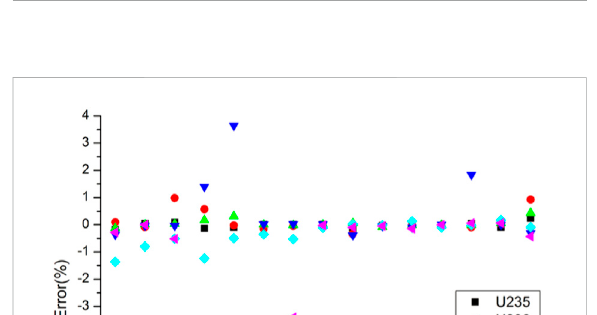
FIGURE 7 Comparison of resonant nuclides ’ total cross sections in 8 wt % PuO 2 .